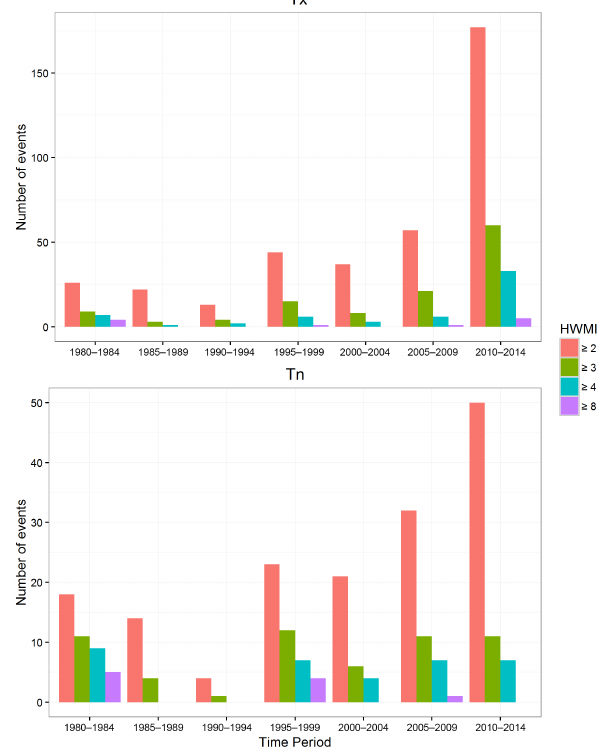
Figure 3. Histogram of heat waves for 5-year periods during 1980– 2014 for maximum temperature ( T x , upper panel) and minimum temperature ( T n , bottom panel).